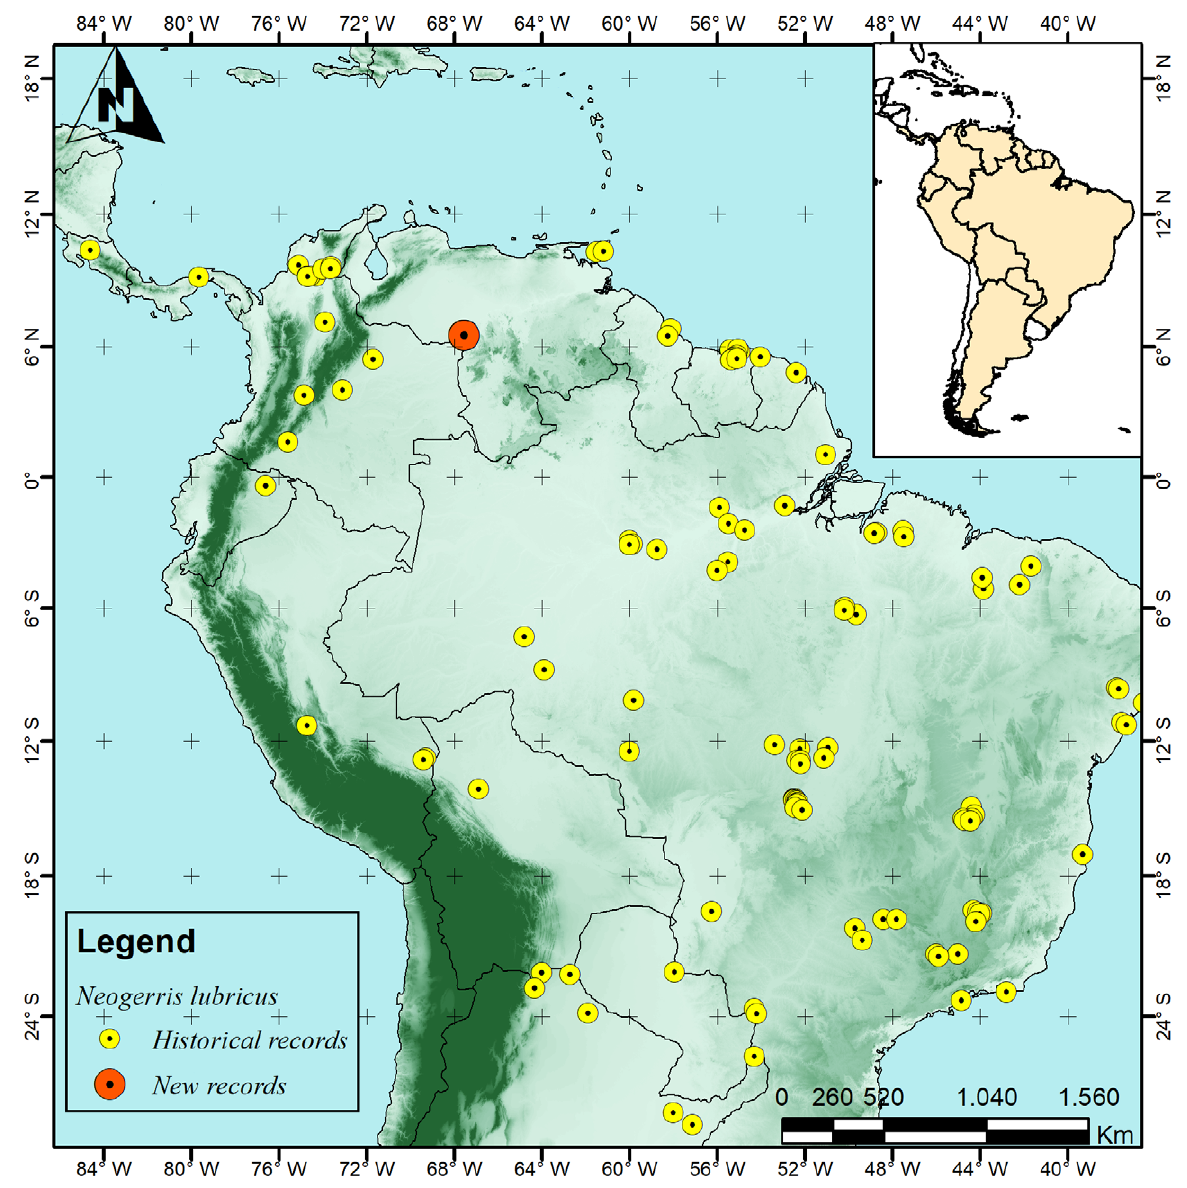
Figure 6. Historical and new records of Neogerris lubricus in the